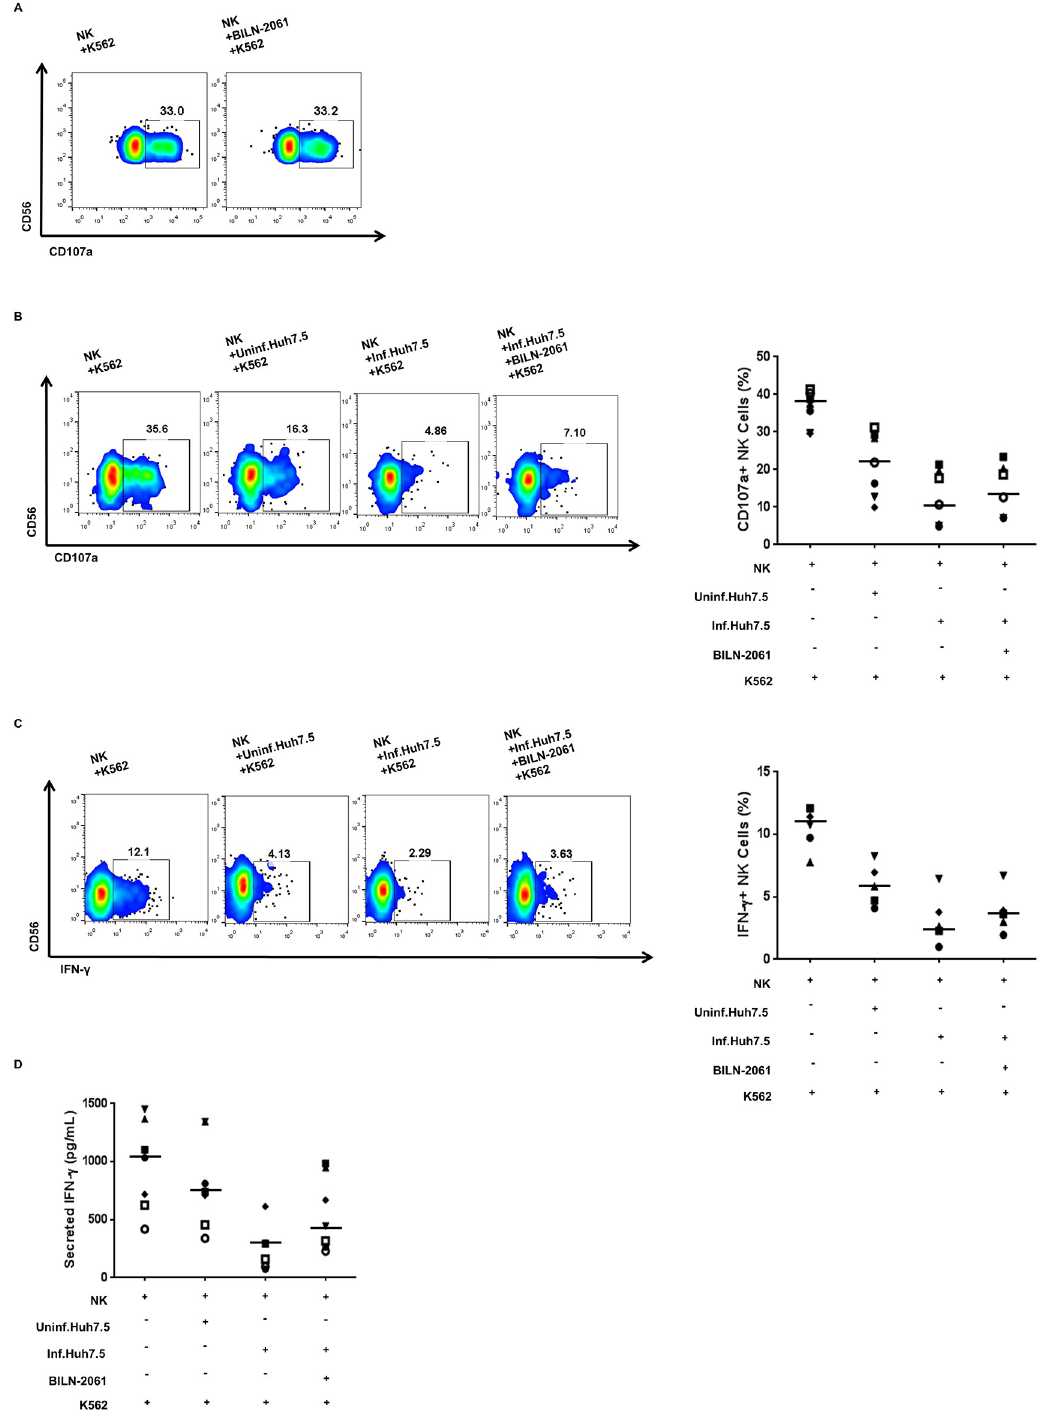
Fig 3. NK cell functions were restored after interaction with BILN-2061-treatedHCV-infected Huh-7.5 cells. (A) NK cell degranulation was measuredas describedabove. NK cells were seededin a 96-wellround bottom culture plate and treated with 400 nM of BILN-2061for 18 h and then co-cultivation with K-562 cells at a 1:1 ratio for 4 h. (B) NK cell degranulation after co-cultivation with BILN-2061-treated HCV-infected Huh-7.5 cells. NK cells were pre-incubated with uninfected, HCV-infected, or BILN-2061-treated HCV-infected Huh-7.5cells for 18 h, and harvestedthe NK cells then co-cultured with K-562 cells at a 1:1 ratio for 4 h. NK cell degranulation was measuredby estimatingCD107a expression. (C) IFN- γ productionby NK cells after co-cultivation with BILN-2061-treated HCV-infected